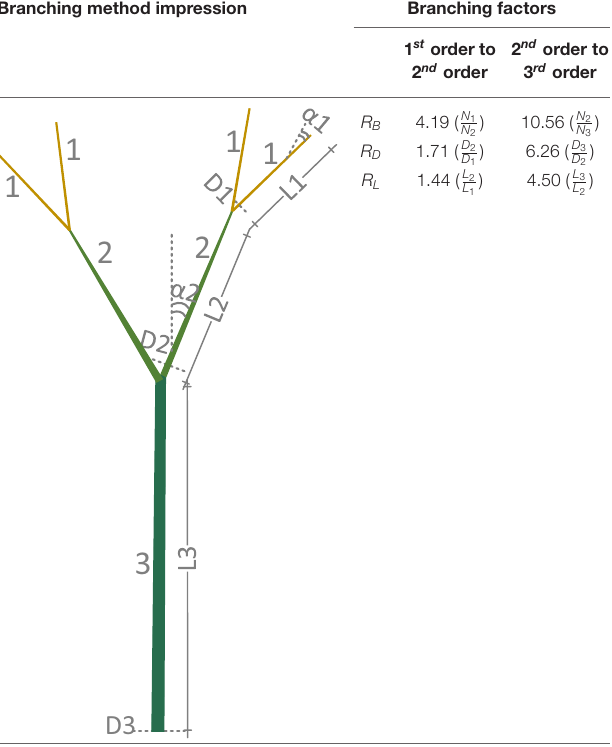
TABLE 2 | Impression of branching method and the resulting branching factors. Branching method impression Branching factors